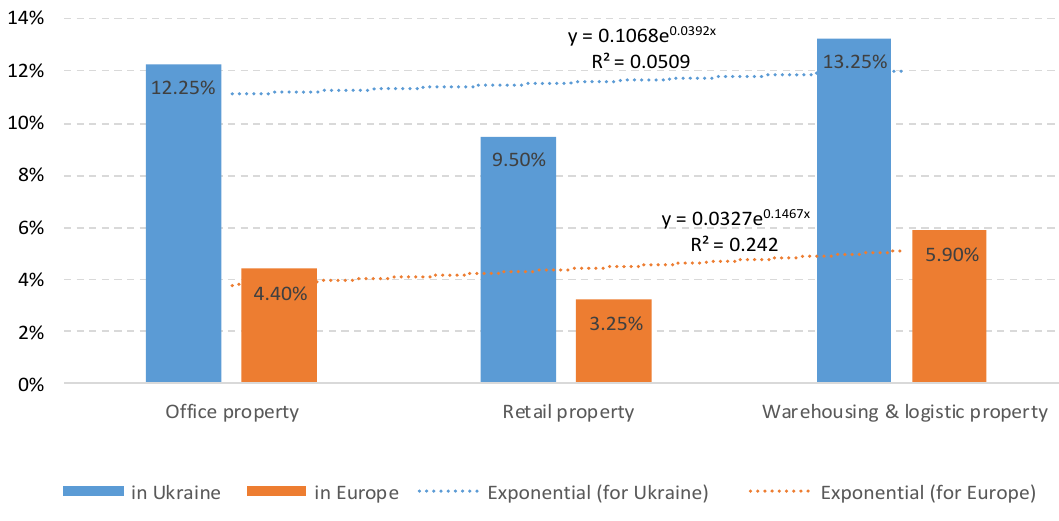
Figure 1. Rate of return on property